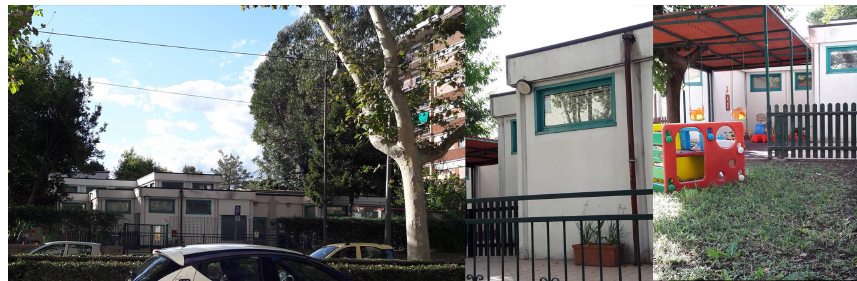
Figure 8. The Pinturicchio